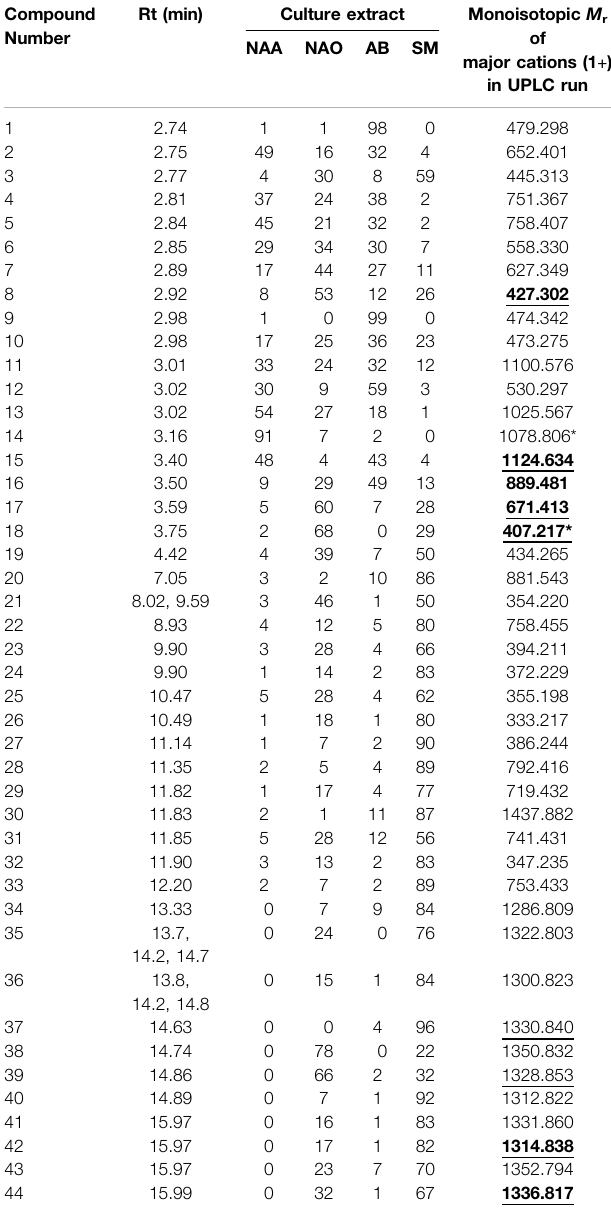
TABLE2| HeatmapofUPLC-MS fi ngerprintingofsecondarymetabolitepro fi lesin theextracts ofthethree different Xenorhabdus cultures(refer to Figures3 , 4 ). Compound Number